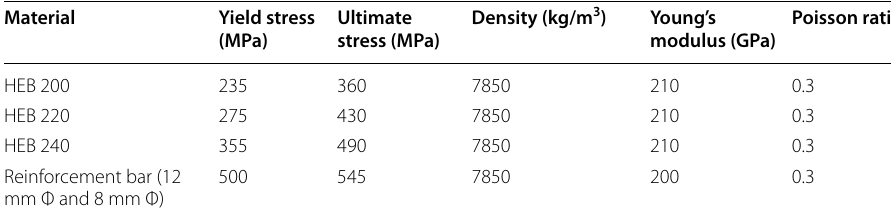
Table 3 Mechanical properties of steel section and reinforcement bars Material Yield stress